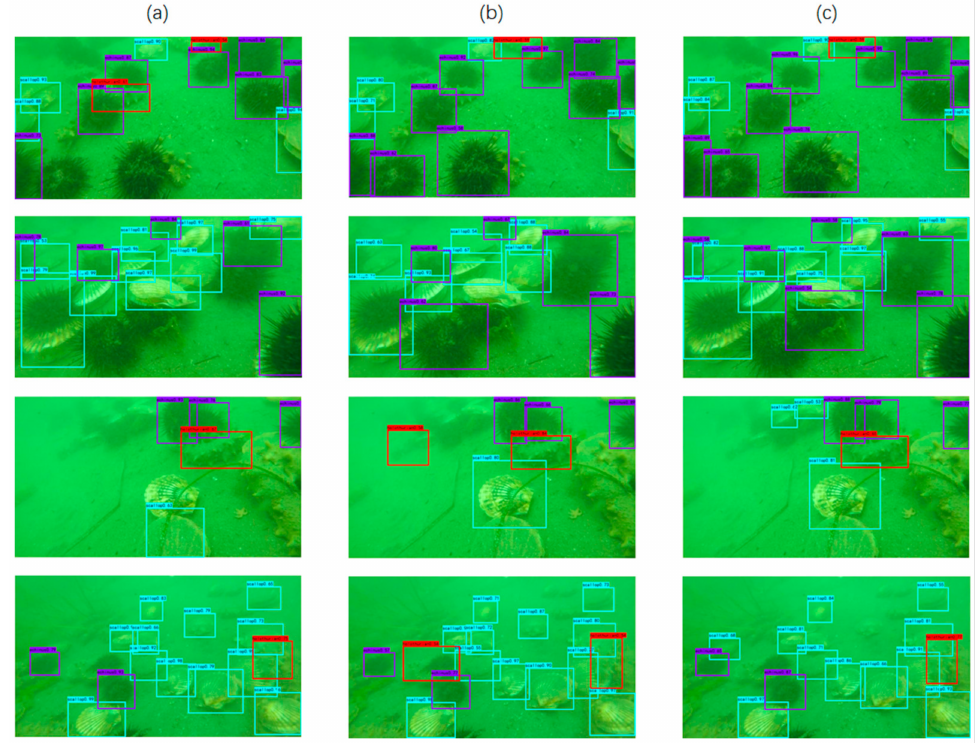
Figure 8. Target recognition results: ( a ) without preprocessing training set; ( b ) preprocessing training set by mosaic augmentation; ( c ) preprocessing training set by e-mosaic